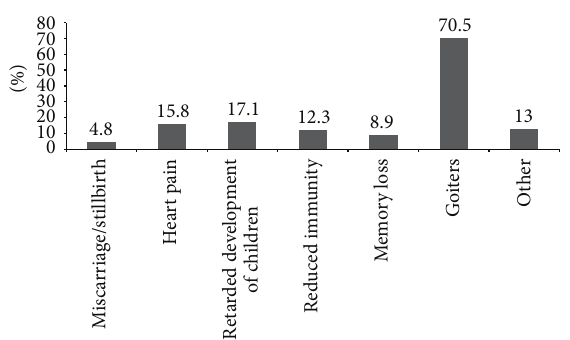
Figure 2: Problems list that the students chose as a result of iodine deficiency.